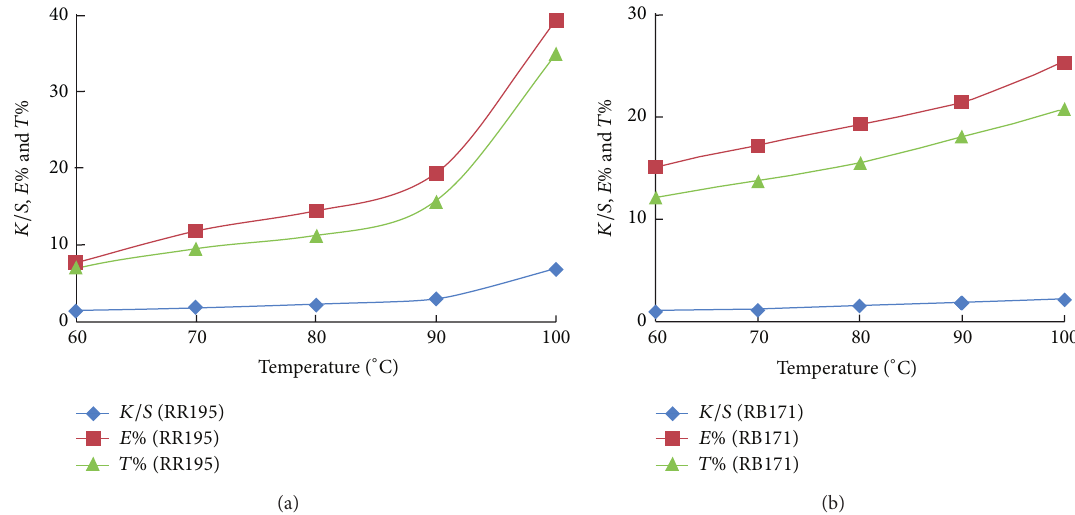
Figure 3: Effect of temperature on the exhaustion, total fixation and colour strength of CI Reactive Red 195 (heterobifunctional reactive dye) and CI Reactive Blue 171 (homobifunctional reactive dye) on amidoximated acrylic fabrics; dyeing conditions: shade 2% owf, liquor ratio 40 :1, pH 2.5, for 60